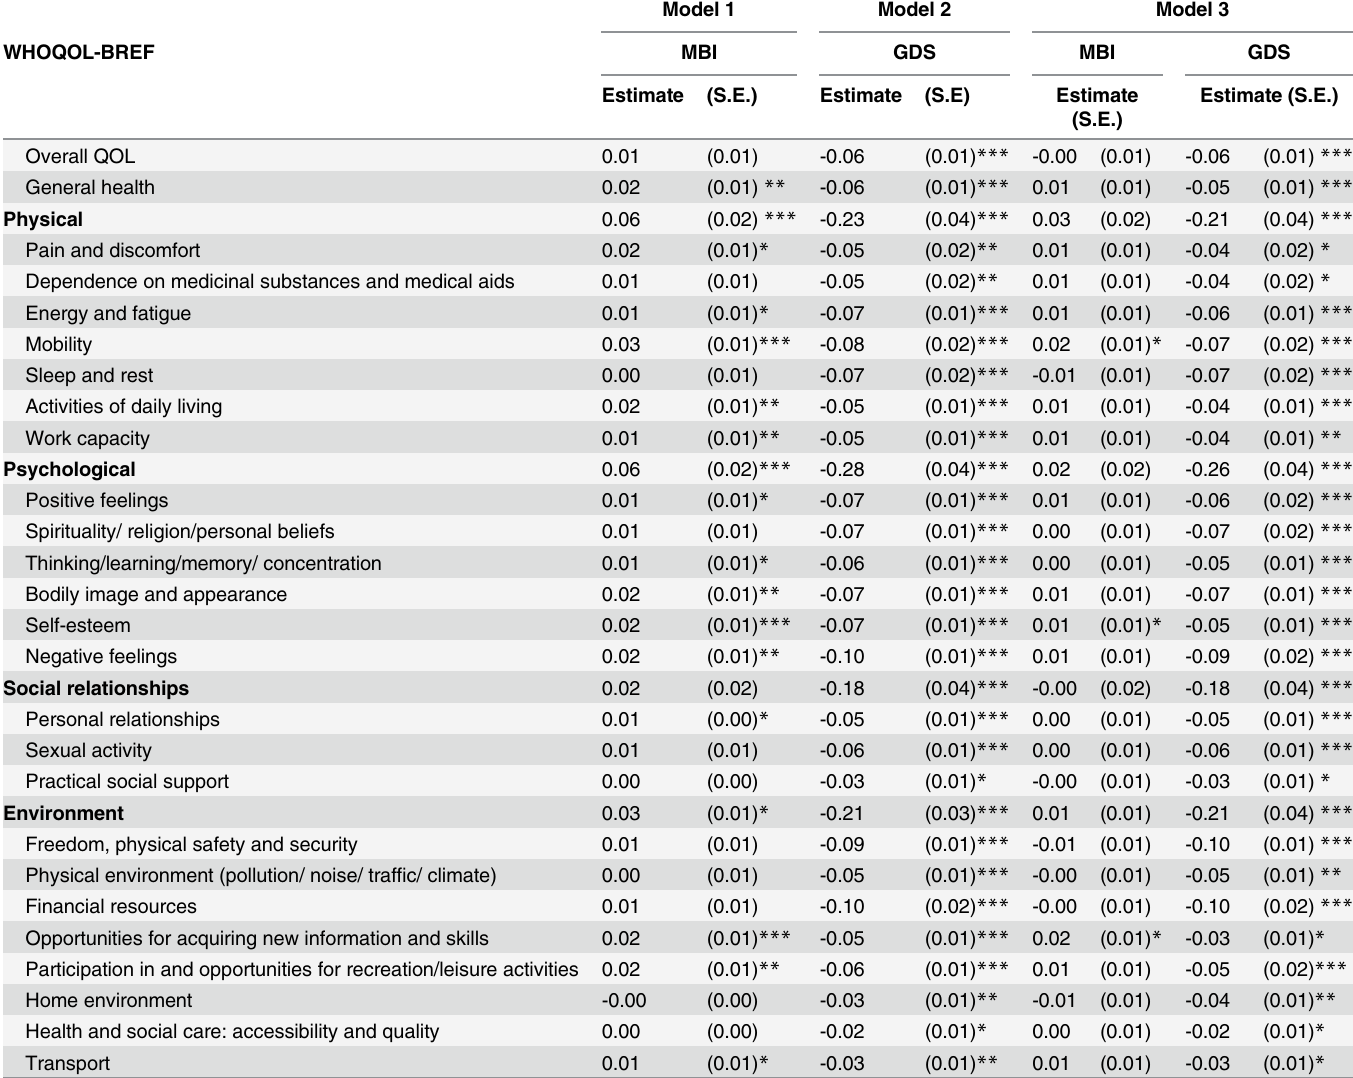
Table 2. Regression coefficients and standard errors (S.E.) of depression scale measured with the GDS and the MBI for individual facets and do- mains of the WHOQOL-BREF under multiple linear regression models adjusted for potential confounders †